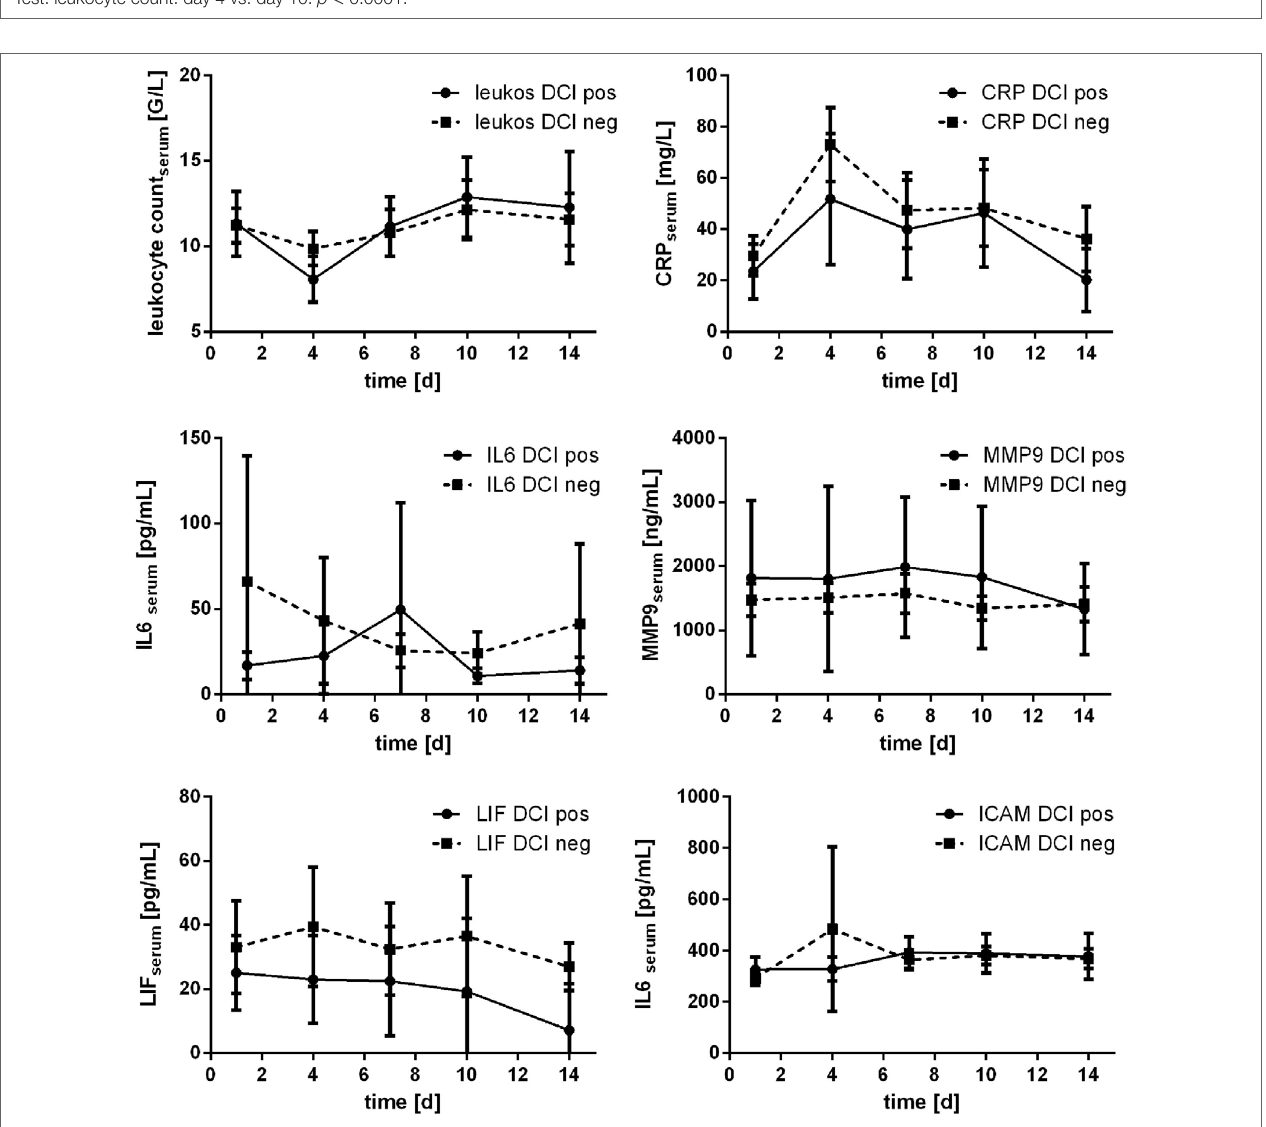
FigUre 7 | Courses of serum inflammatory parameters related to occurrence of delayed cerebral ischemia (DCI) ( ± 95% confidence interval).